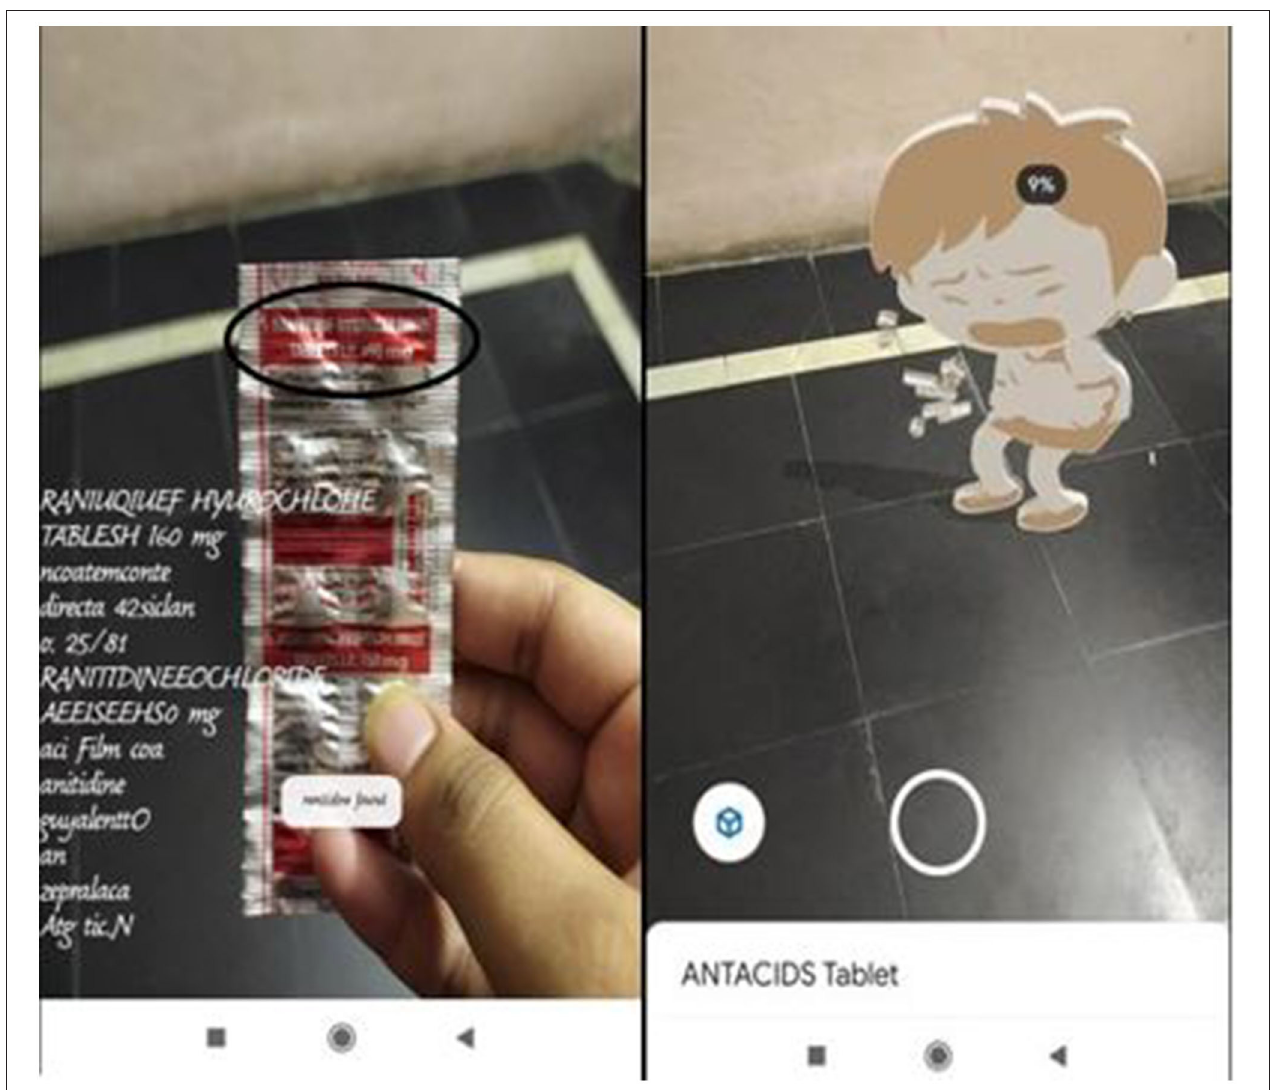
FIGURE 5 | Real drug and 3D model of the drug along with name detection as ANTACIDS.